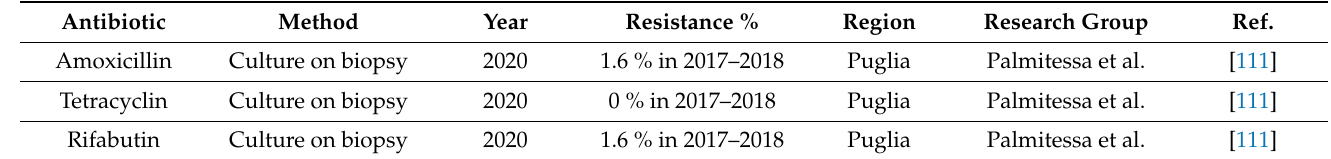
Table 4. Primary resistance to the other antibiotics in